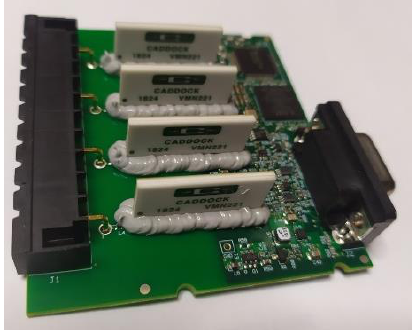
Figure 15. NI-9242 module with four VMN221s from CADDOCK.